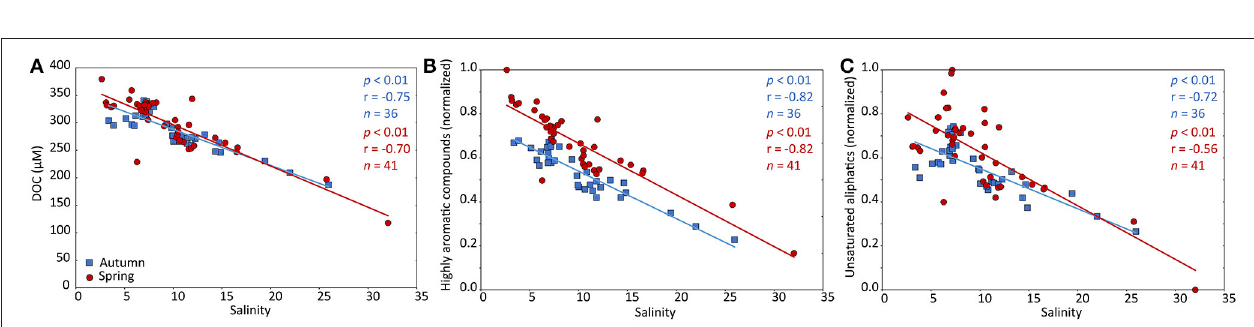
FIGURE 6 | DOC concentrations and the distribution of DOM molecular compound groups along the salinity gradient. Relationship of bulk DOC concentrations (A) , the relative abundance of highly aromatic compounds (B) and unsaturated aliphatic compounds ( C ; molecular formulae of groups 2 and 4, respectively) and salinity for autumn (blue squares) and spring (red circles) samples. The solid lines represent linear regressions. The relative abundance of the compound groups was scaled to the DOC concentrations and normalized to their minimum and maximum values. Bulk DOC concentrations and the highly aromatic compounds strongly correlated with salinity indicative for mixing of riverine and marine DOM. Unsaturated aliphatic compounds were more variable compared to linear mixing suggesting complex processing along the salinity gradient.